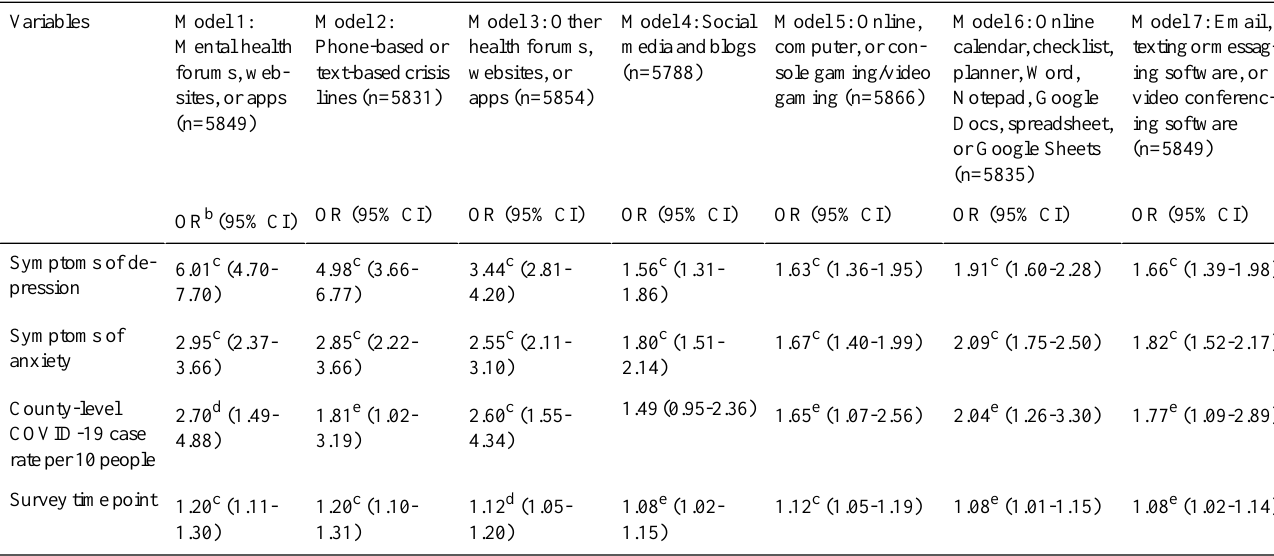
Table 3. Associations between use of digital mental health tools and other technologies and prevalence of mental illness symptoms and the rate of COVID-19 cases: estimates based on seven separate logistic models a .